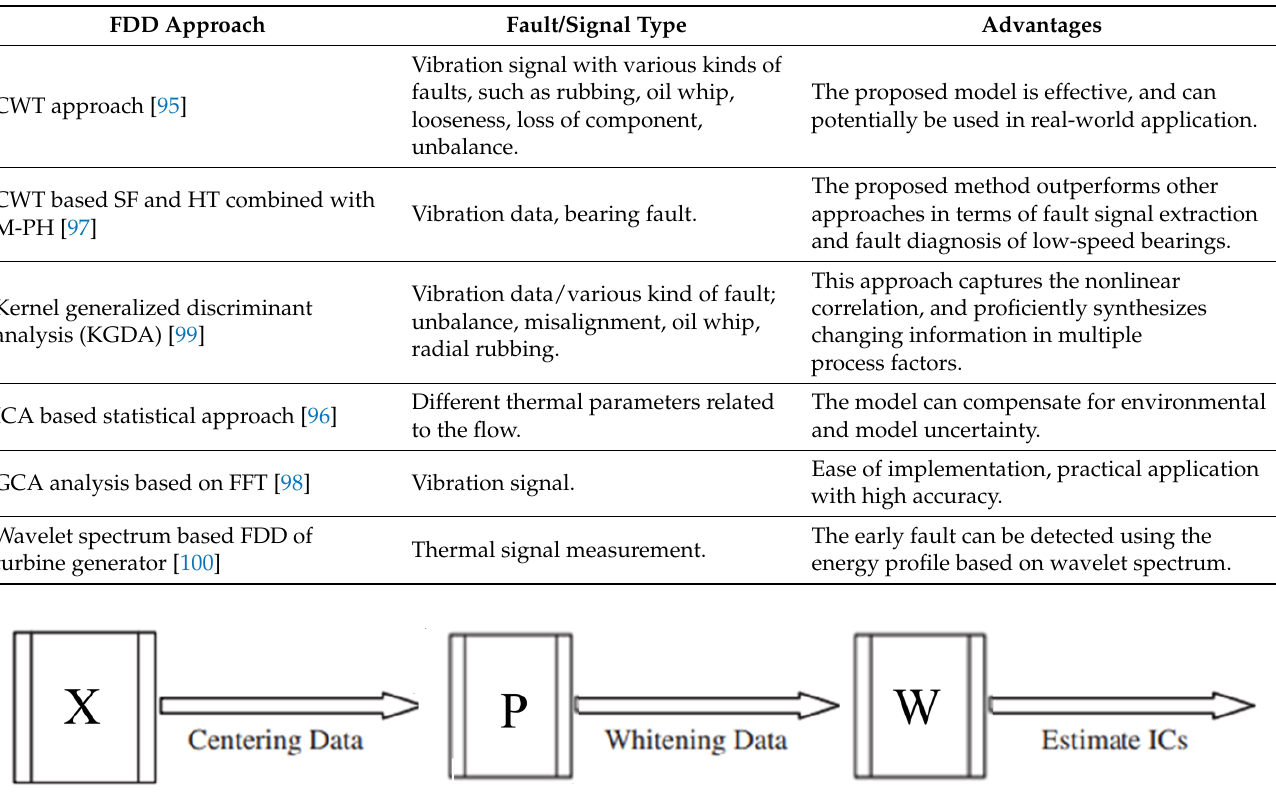
Figure 8. Illustration of the Mixing and Separation Process using ICA Algorithm [96].